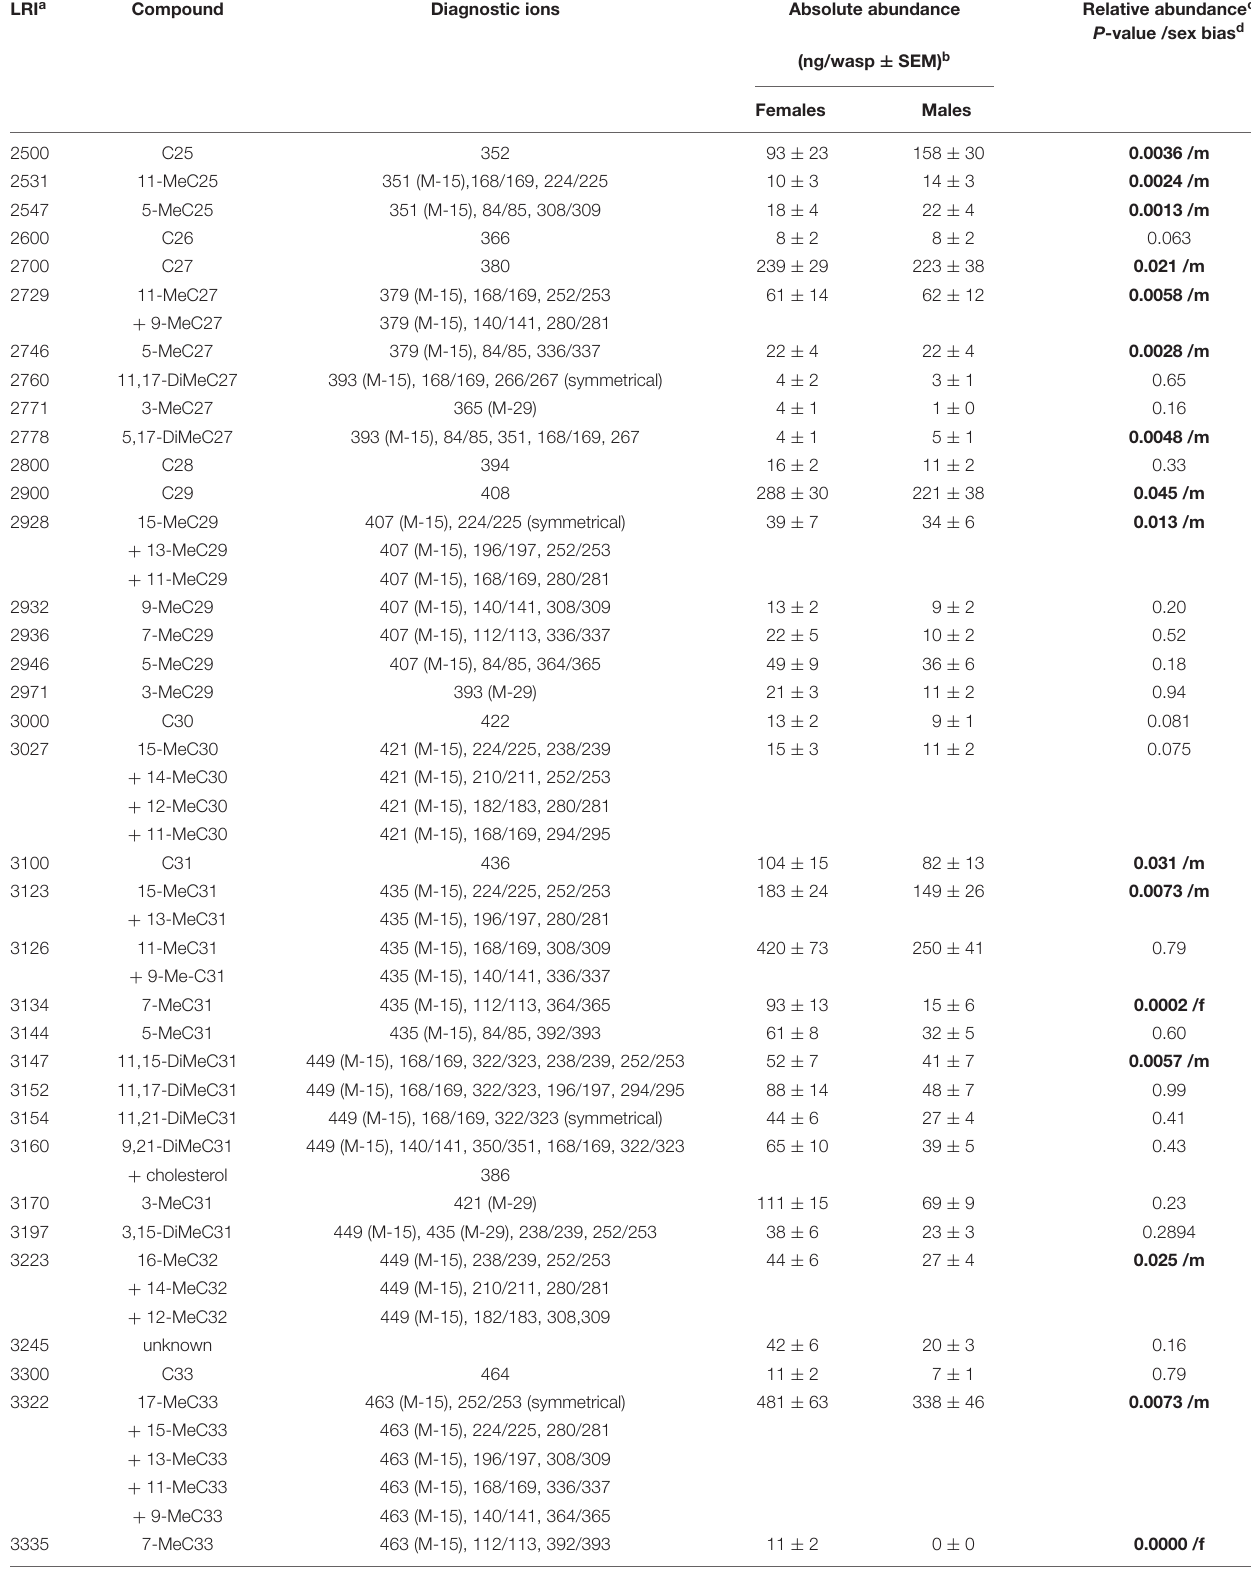
TABLE 1 | Cuticular hydrocarbons identified in male and female Urolepis rufipes wasps. LRI a Compound Diagnostic